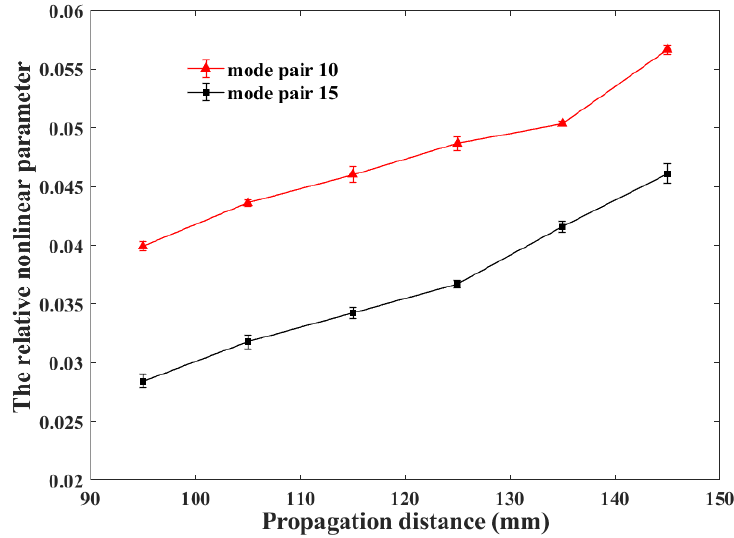
Figure 13. Nonlinear parameter versus propagation distances.